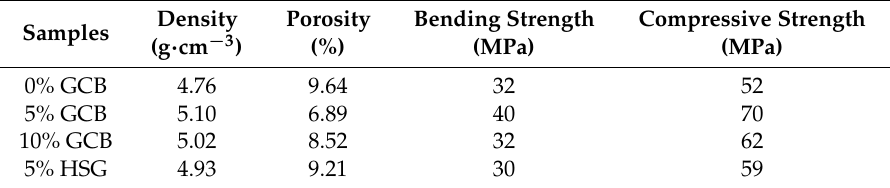
Table 2. Sintering and mechanical properties with different lubricating